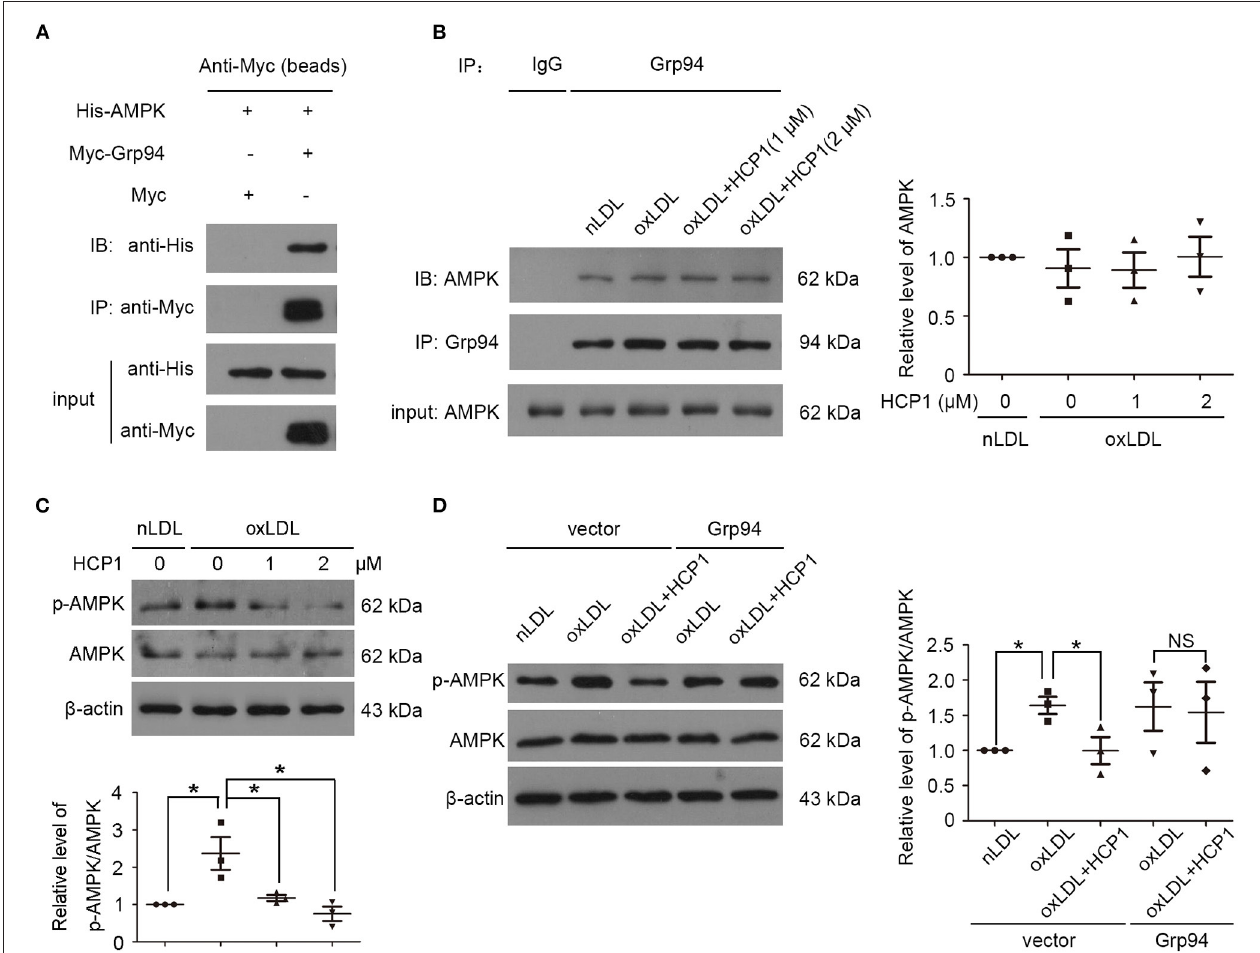
FIGURE 3 | Grp94 might interact with AMPK and activate its activity. (A) Co-immunoprecipitation (Co-IP) of His-tagged AMPK proteins with Myc-tagged Grp94 from HEK293T cells transfected His-AMPK with Myc (lane 1) or Myc-Grp94 (lane 2). The lower panel showed expression levels of His-AMPK and Myc-Grp94 in the experiment. (B) Co-IP of AMPK with Grp94 from HUVECs treated with nLDL (50 µ g/ml), oxLDL (50 µ g/ml) with or without HCP1 (1, 2 µ M) for 3h. Co-immunoprecipitated AMPK was quantified in immunoblot with anti-AMPK antibody in western blot. (C) Protein levels of phosphorylated AMPK α (p-AMPK α , Thr172) and total AMPK α in HUVECs treated with nLDL (50 µ g/ml), oxLDL (50 µ g/ml) with or without HCP1 (1, 2 µ M) for 6h. Bar charts show quantification of the ratio of p-AMPK α to total AMPK α . (D) Protein levels of phosphorylated AMPK α (p-AMPK α , Thr172) and total AMPK α in HUVECs transfected with c-Myc empty vector or c-Myc-Grp94-wt plasmid for 24h were detected after treatment with nLDL (50 µ g/ml), oxLDL (50 µ g/ml) with or without HCP1 (1 µ M) for 6h. Data are mean ± SEM; * p < 0.05, NS p > 0.05; n = 3. Statistical analyses were performed using one-way